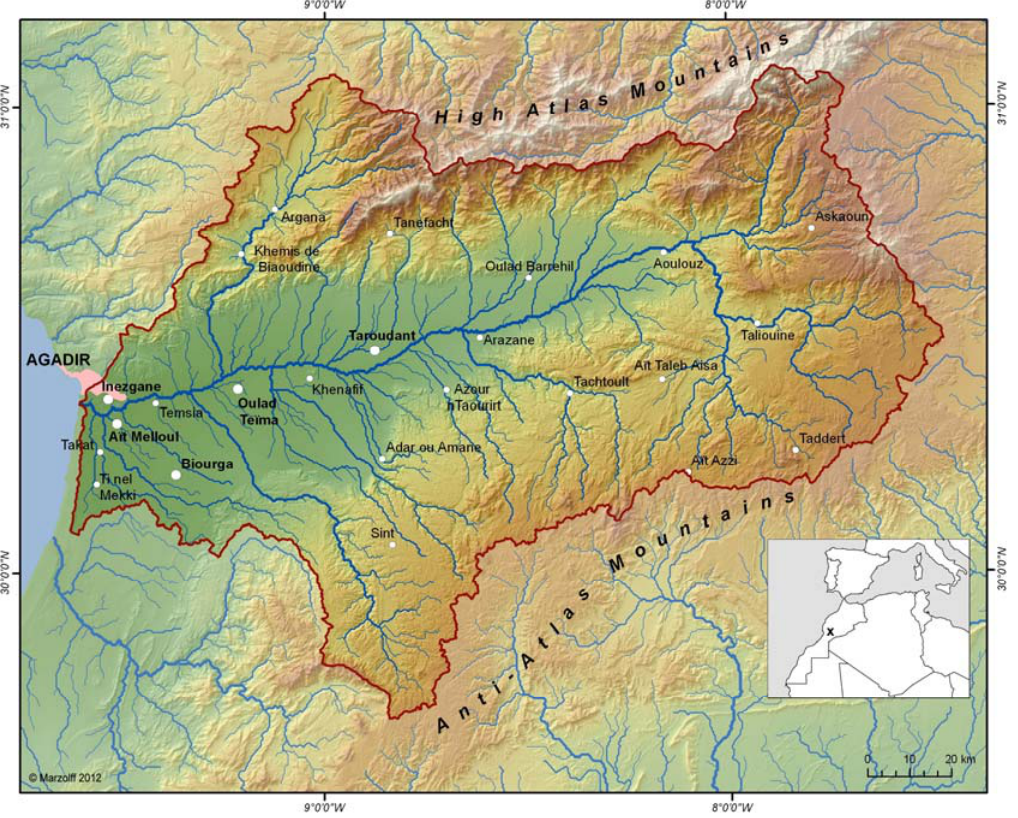
Figure 1. Souss catchment in South Morocco (Basemap: USGS